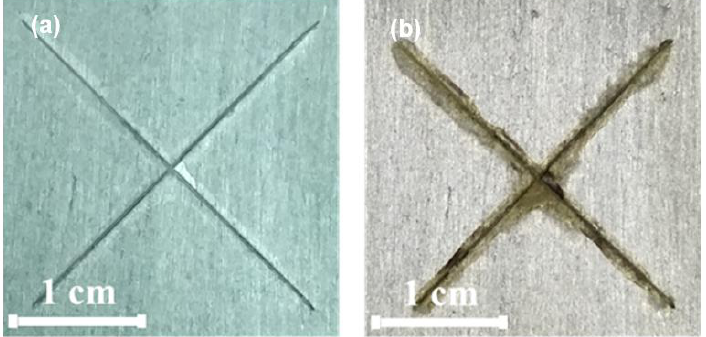
Figure 6. Photos of the double-layer coating sample before ( a ) and after ( b ) 48 h Machu test.